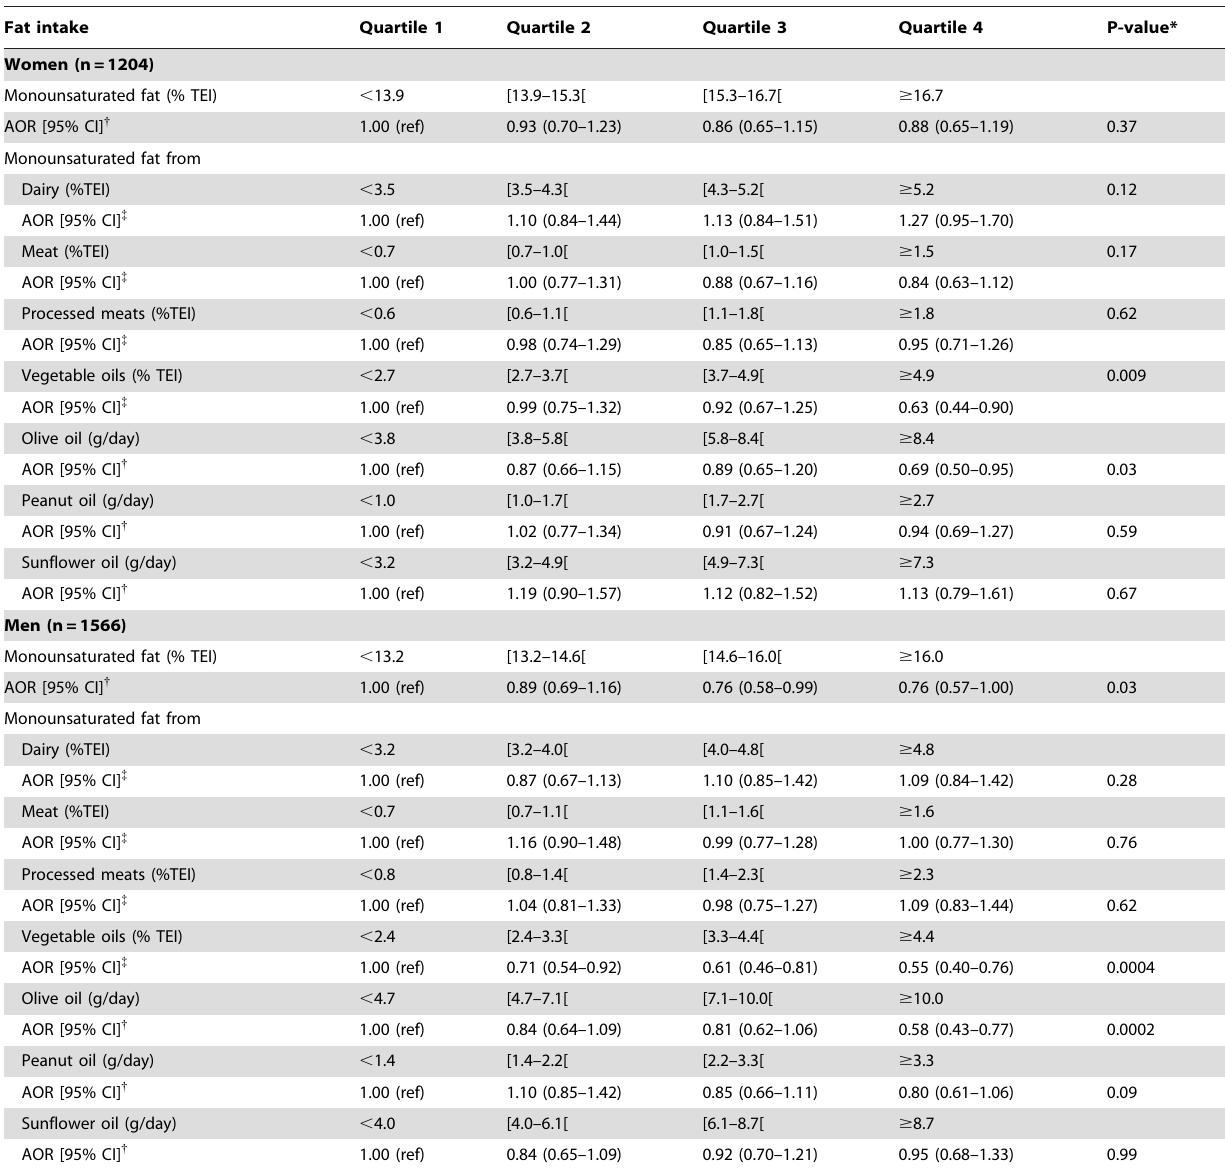
Table 3. Risk of photoaging according to lipid